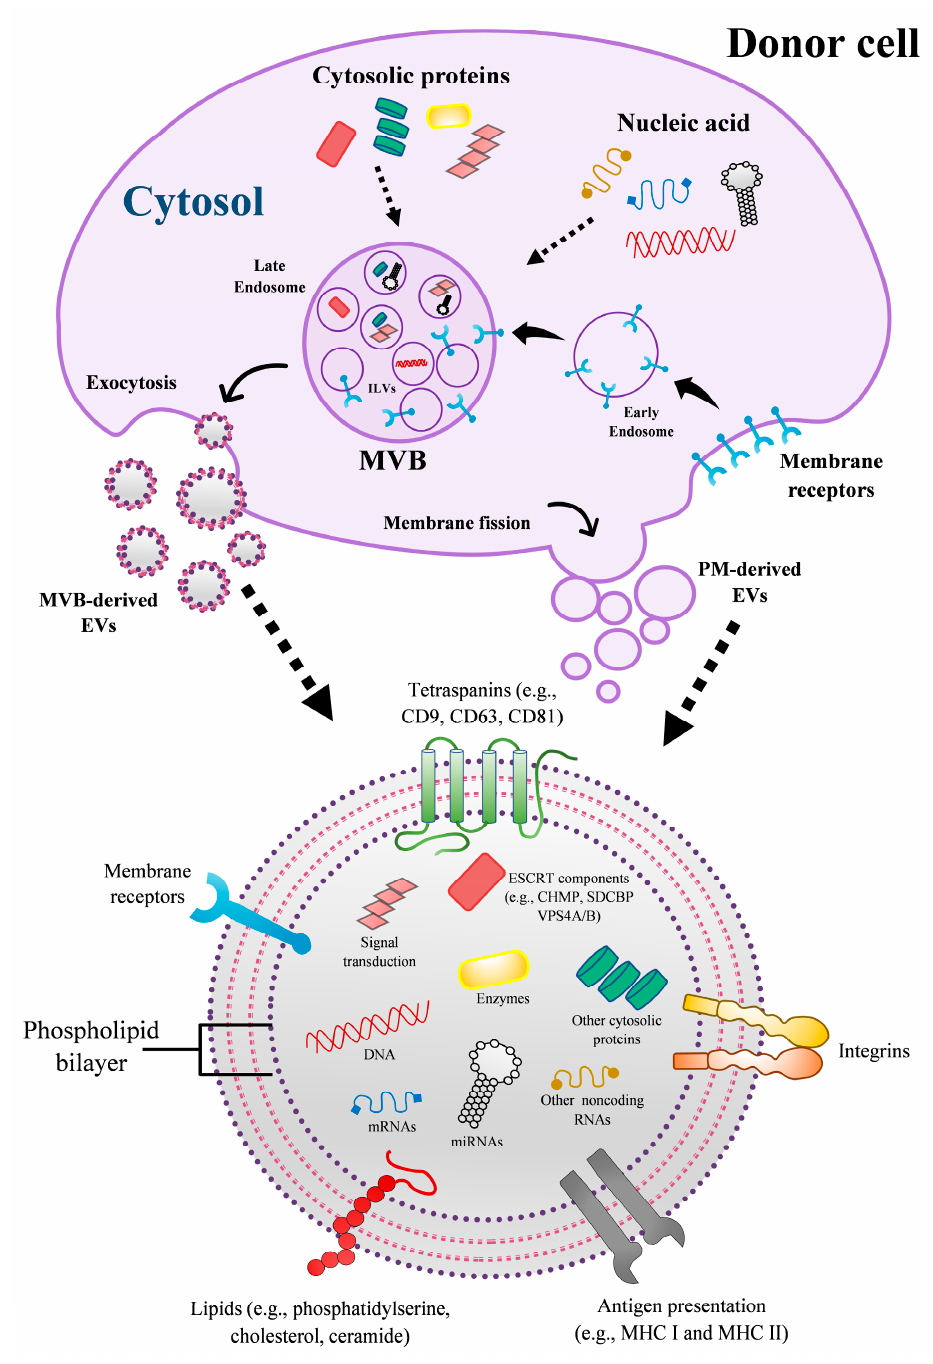
Figure 1. Schematic representation of origin and composition of EVs secreted by eukaryotic cell. PM-derived EVs originate directly from the cell membrane fission, whereas EVs of endosomal system originate from ILVs contained in cytosolic MVBs, which later fuse with the PM releasing the vesicles in the outer space. EVs can carry proteins, lipids, and nucleic acids. Some of the listed components represented in the figure may be enriched in some subtypes of EVs and not in others. For instance, ESCRTs components (e.g., CHMP, SDCBP, VPS4A/B) are highly enriched in MVB-derived EVs rather than PM-derived EVs. Abbreviations: CHMP, charged multivesicular body protein; ESCRT, endosomal sorting complex required for transport; ILVs, intraluminal vesicles; MVBs, multivesicular bodies; MHC, major histocompatibility complex; PM, plasma membrane; SDCBP, syndecan binding protein; VPS4A/B, vacuolar protein sorting-associated protein